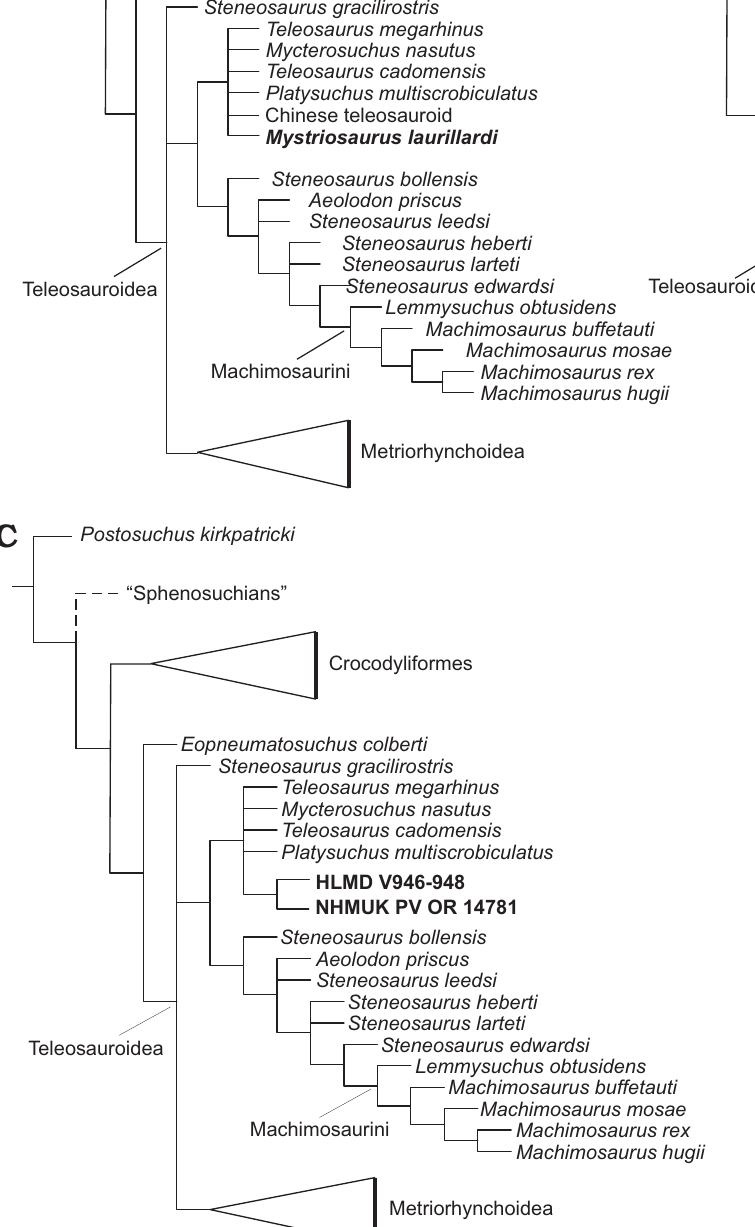
Fig. 5. Phylogenetic analyses using strict consensus trees of: A , the position of Mystriosaurus (197 MPCs, 1513 steps); B , HLMD V946-948 and NHMUK PV OR 14781 treated as two separate taxa (213 MPCs, 1514 steps); and C , HLMD V946-948 and NHMUK PV OR 14781 treated as two sepa- rate taxa and removal of the IVPP Chinese teleosauroid (192 MPCs, 1508 steps). For comparative skulls see SOM: fig.